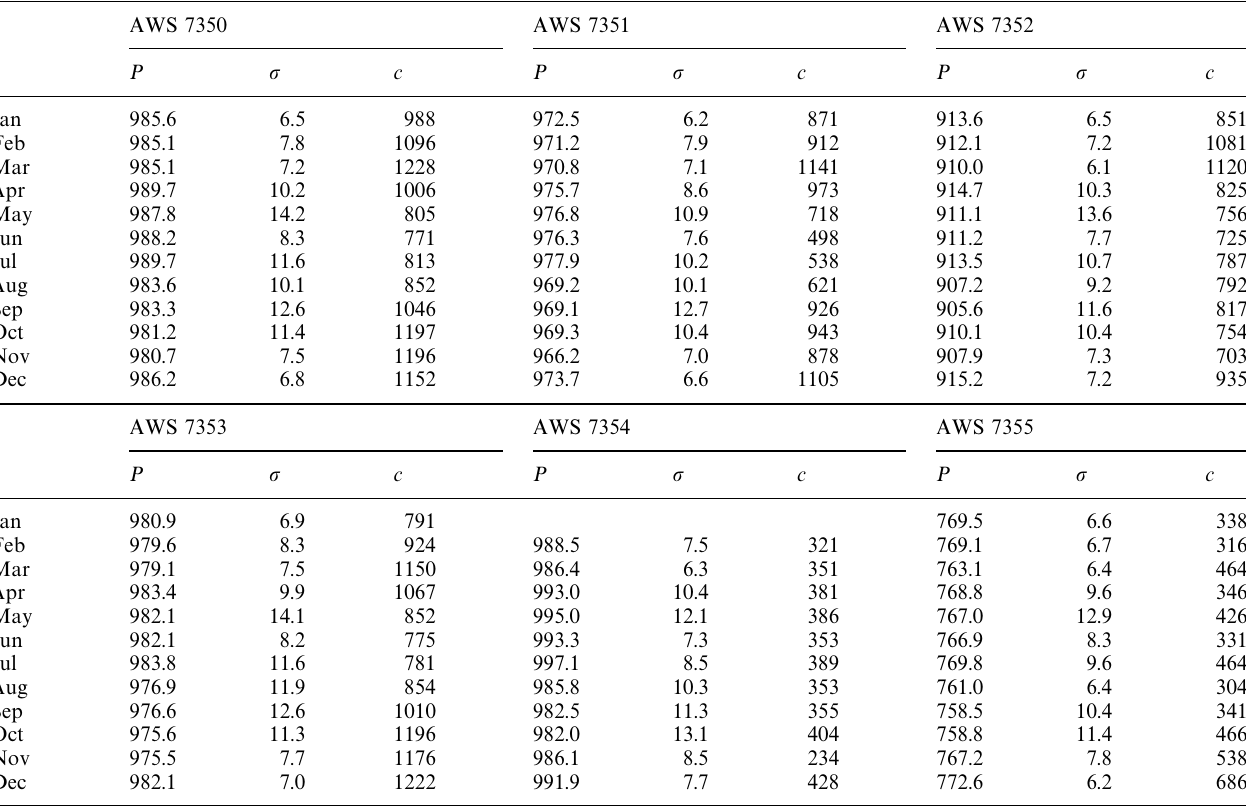
Table 3. Monthly average pressure (hPa), standard deviation and number of cases at all AWS